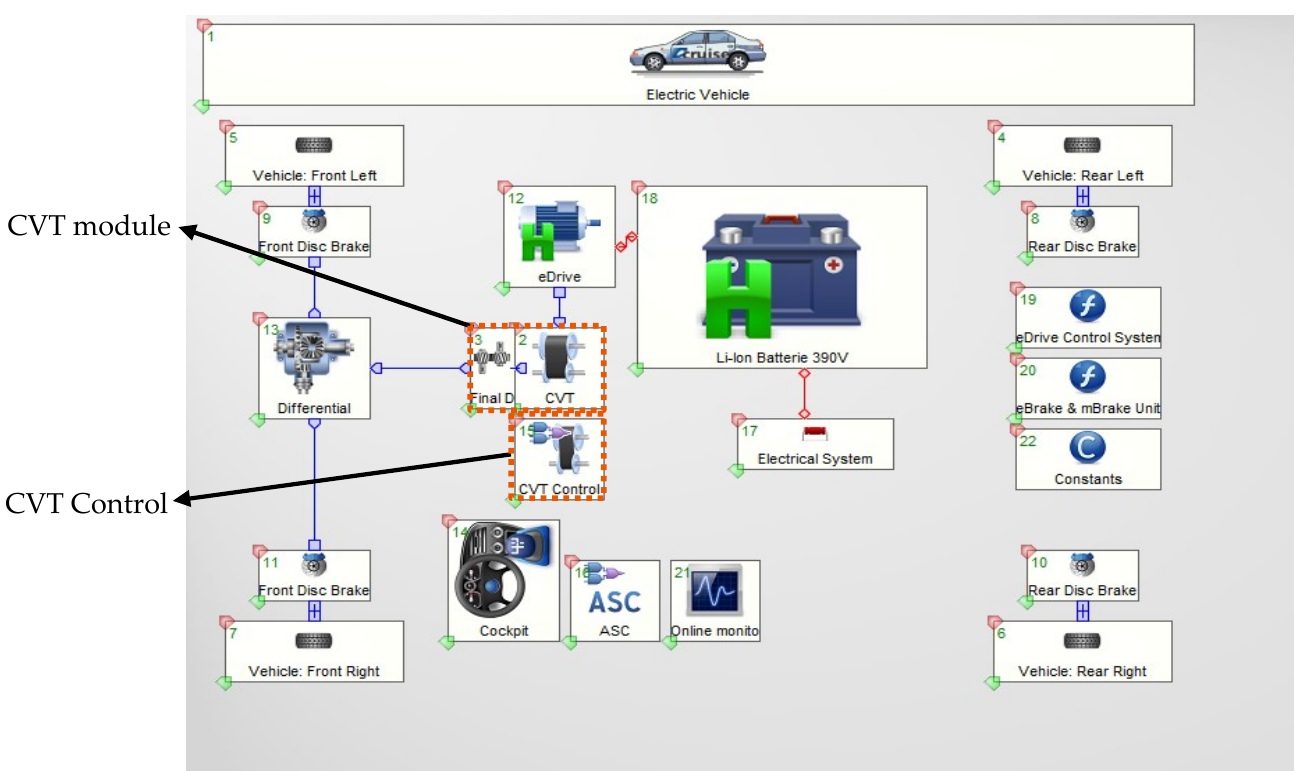
Figure 6. CVT-applied EV model layout developed by this study.